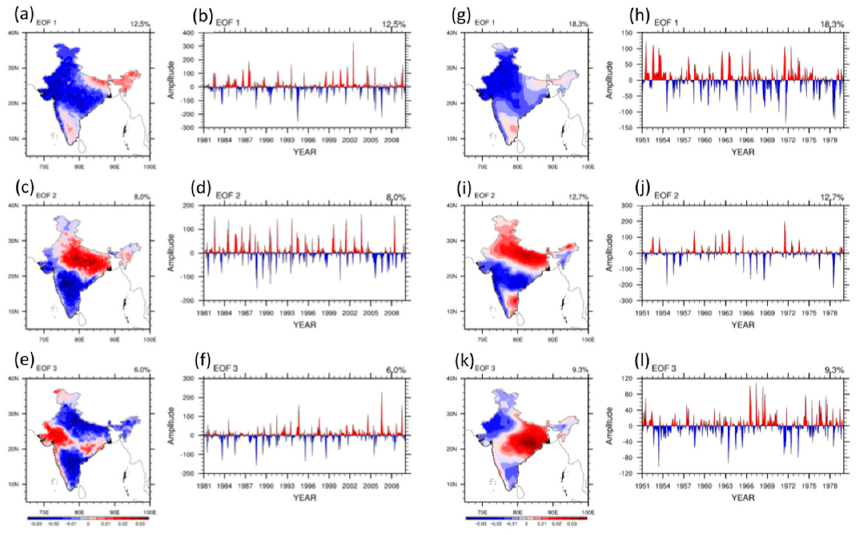
Figure 5. First three EOFs and their corresponding PCs of the temperature for the period 1981–2010 from ( a – f ) AGCM ensemble and ( g – l ) IMD observation.